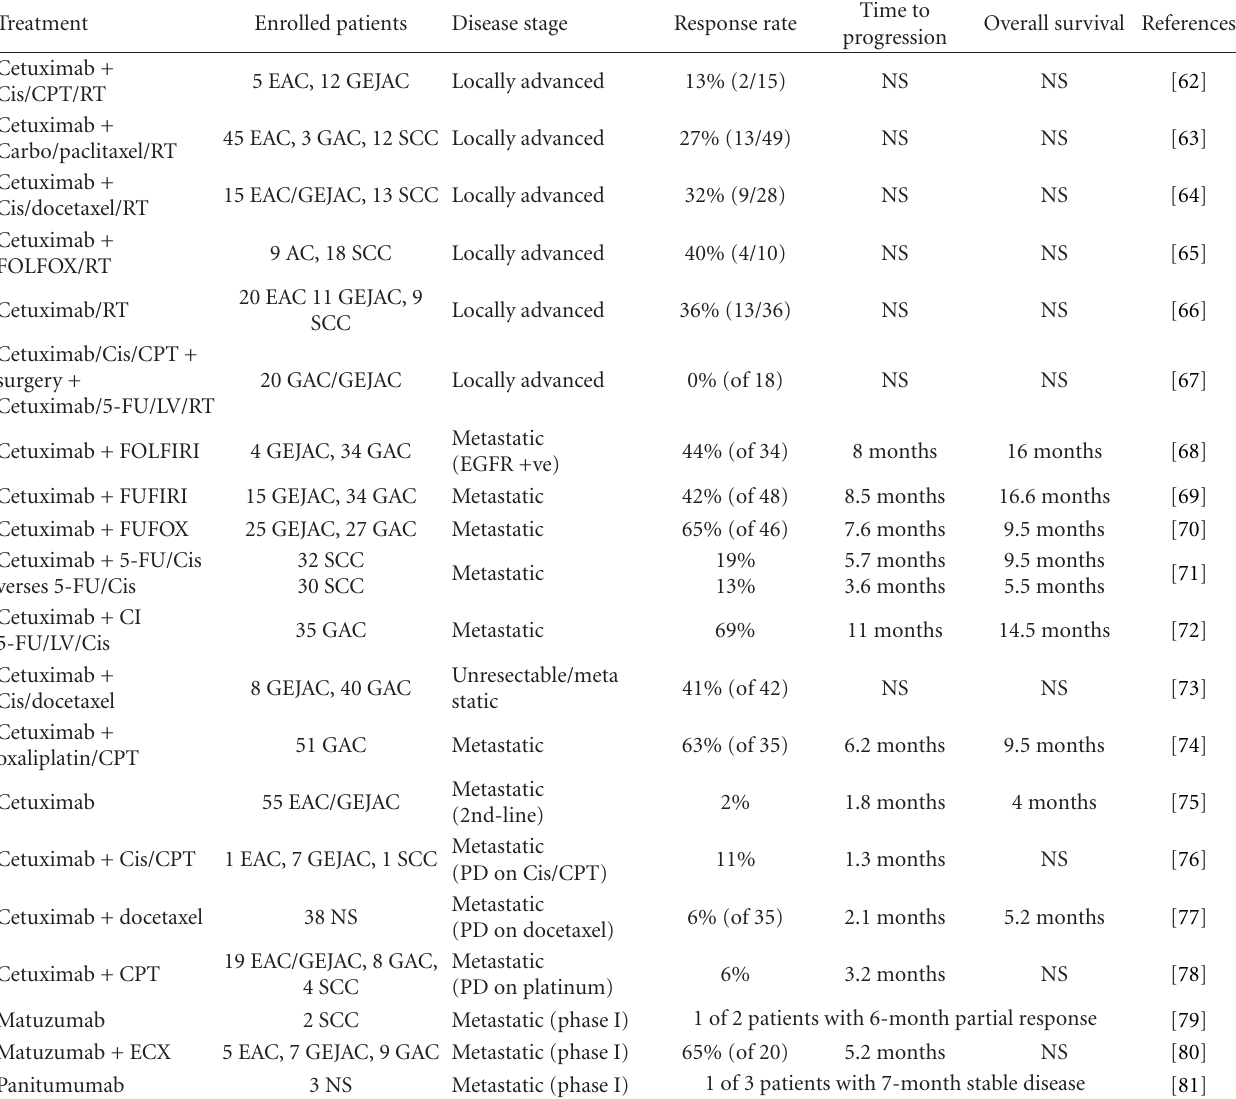
Table 2: Major trials using anti-EGFR monoclonal